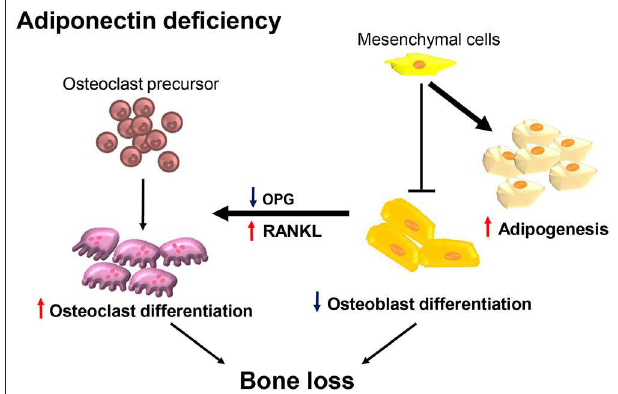
FIGURE 7 | Adiponectin-deficient bone microenvironments exhibit conditions favoring bone destruction. Schematic illustration of the proposed mechanism in terms of adiponectin deficiency. Osteoclast precursors are preferentially differentiated into M1-like macrophages having attenuated osteoclast differentiation under conditions of adiponectin deficiency. However, in the adiponectin-deficient bone microenvironment, adiponectin-deficient mesenchymal lineage cells are preferentially differentiated into adipocytes rather than osteoblasts and the increased RANKL/OPG ratio is maintained. Therefore, osteoclast precursors are efficiently differentiated into active osteoclasts accompanied by increased bone destruction.